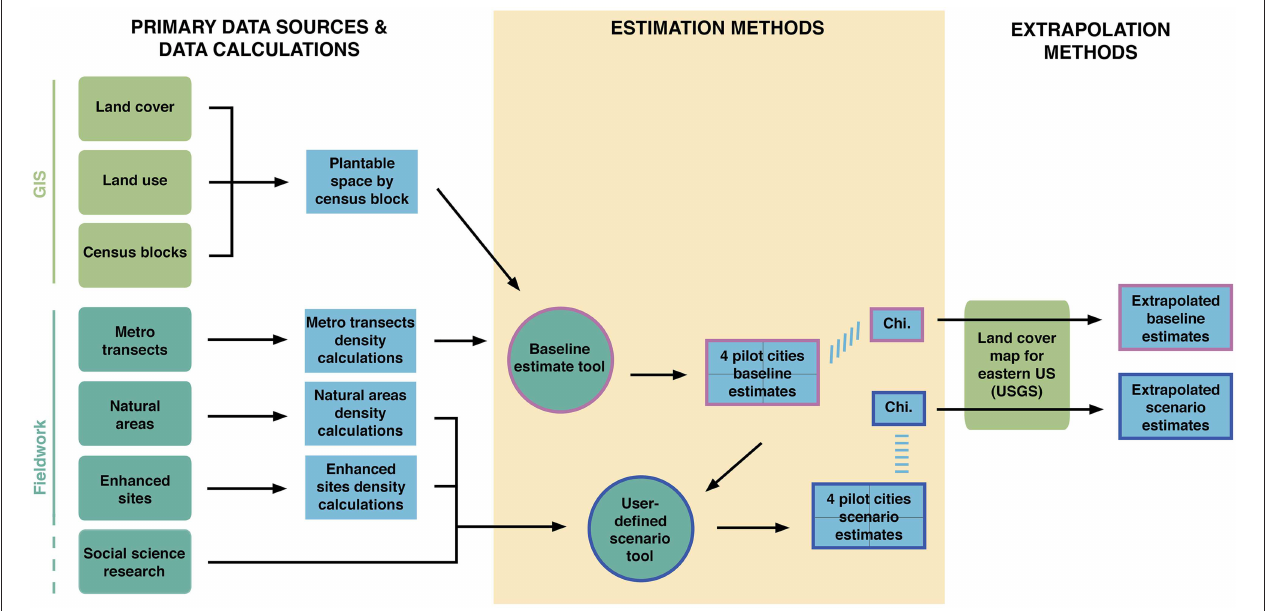
FIGURE 3 | Organization of our methods and approach including data gathering and analysis. The Primary Data Sources and Data Calculations section addresses GIS data and fieldwork used to produce geospatial data which is combined for incorporation into our tools in Estimation Methods. We ran the Baseline tool for all cities which are then used as input to the Scenario tool. From both tools, Chicago estimates are ultimately used for superimposing onto the USGS land cover raster for extrapolation to regional scale